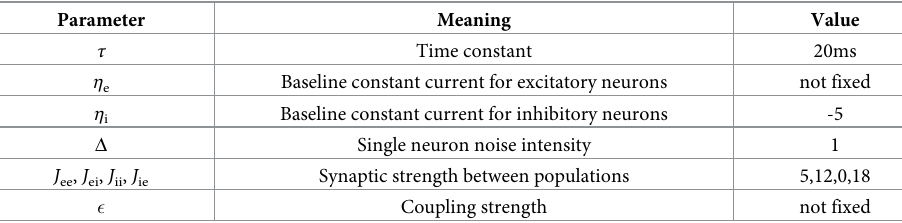
Table 2. Parameters of the